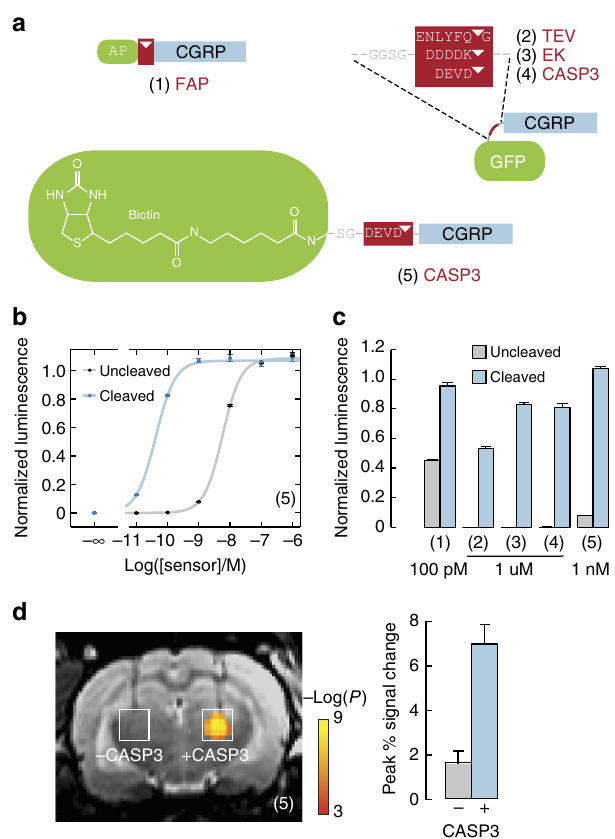
Figure 3 | Design and assessment of protease-activated imaging probes based on CGRP. ( a ) Protease sensor designs incorporate an N-terminal blocking moiety (green), a protease cleavage sequence (red, cleavage sites indicated by triangles), and a C-terminal CGRP moiety (blue). Structures of five protease sensors are shown, with cognate proteases labelled in red text: (1) The synthetic peptide AP-CGRP-amide detects dipeptidase activity of fibroblast activation protein (FAP). (2–4) Recombinant fusion proteins comprises cysteine-free GFP, a short linker, a protease site and non-amidated CGRP detect TEV protease (2), enterokinase (EK) (3) and caspase-3 (CASP3) (4). (5) The synthetic peptide (long-chain biotin)-SG- DEVD-CGRP-amide also detects CASP3 activity. ( b ) Dose–response curve for sensor (5) measured using a cell-based bioassay 32 (Supplementary Fig. 2) following incubation with or without CASP3. Luminescence values were normalized, and error bars reflect s.d. from n ¼ 3 replicates. ( c ) Protease sensing by CGRP-based probes measured in vitro , using probe concentrations indicated. Error bars represent s.d. of n ¼ 3 replicates. Sensors were incubated with or without corresponding proteases: (1) with 5ng m l (cid:2) 1 of human FAP; (2) with 0.1U m l (cid:2) 1 of TEV protease; (3) with 2pg m l (cid:2) 1 of EK light chain; (4) with 23ngul (cid:2) 1 and (5) with 11.5ng m l (cid:2) 1 of human CASP3. ( d ) Left, protease-dependent switching of 100nM CGRP-based molecular imaging probe (5) induces contrast differences in MRI. Significant haemodynamic activation can be seen in the presence but not the absence of coadministered 1.15ng m l (cid:2) 1 CASP3. Right, bar graph showing peak signal change induced by uncleaved versus cleaved sensor (5). Error bars throughout this figure indicate s.e.m. values over n ¼ 4